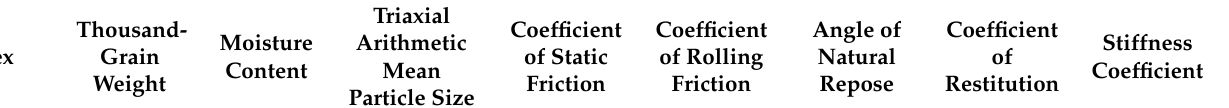
Table 4. Correlation coefficient matrix between the main physical characteristic parameters of maize